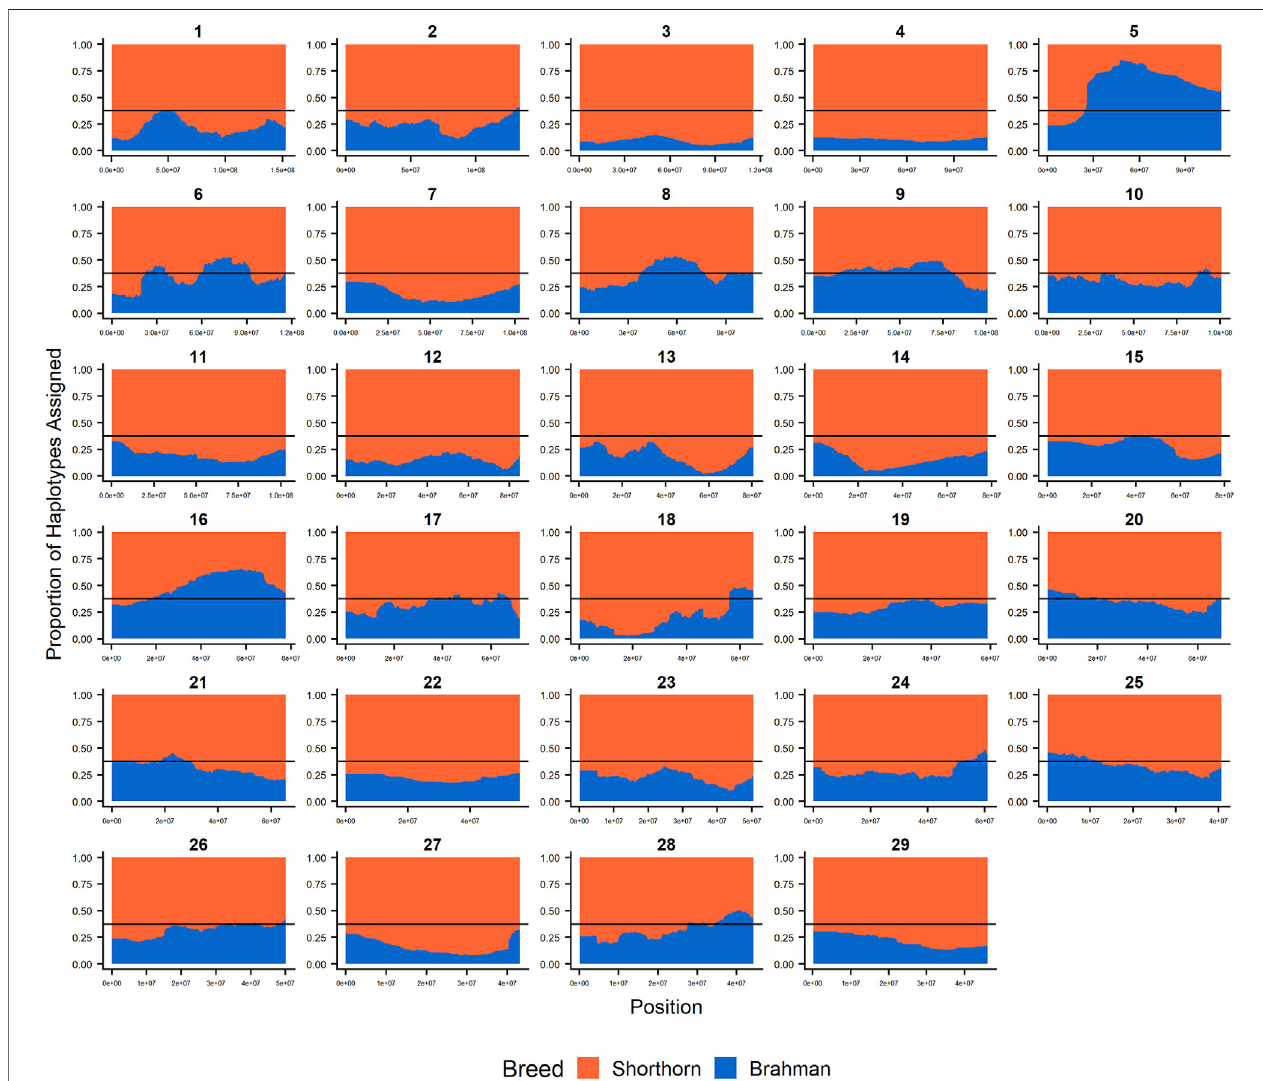
FIGURE2| RFMix most likelyassignment bychromosome fortheANCESTRAL referencepanel foreach 25 SNP window for Santa Gertrudis. Brahman(blue) and Shorthorn (orange). Horizontal line indicates 3/8 expected Brahman proportion.